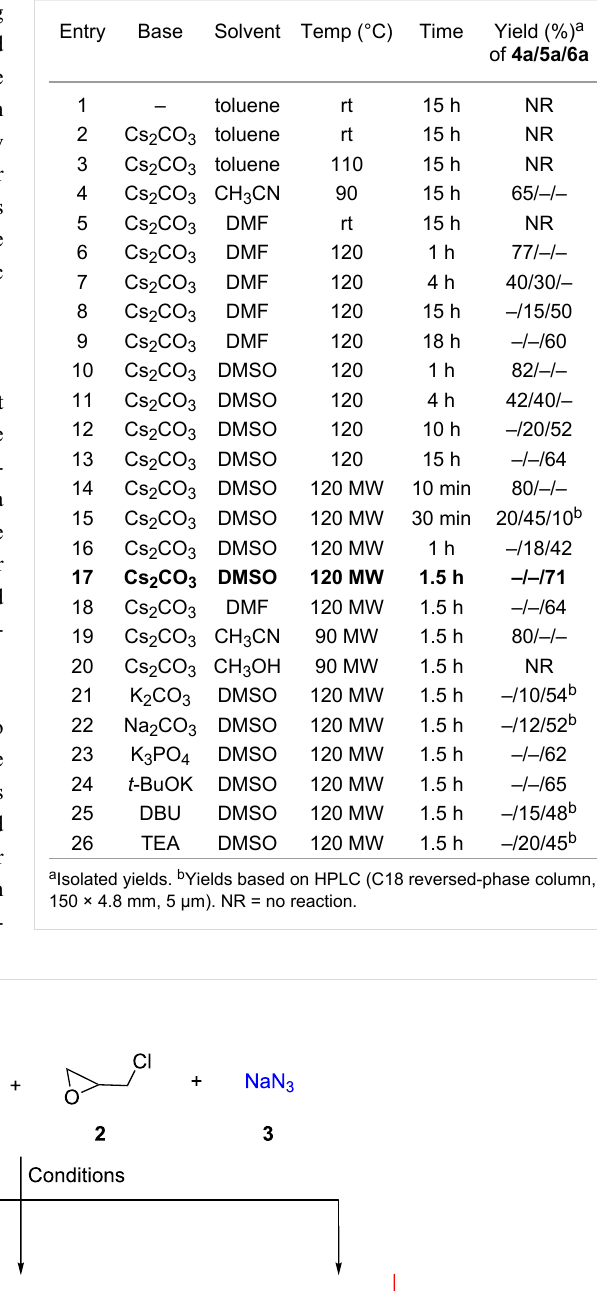
Table 1: Optimization of reaction conditions for the synthesis of 6a in a three-component domino